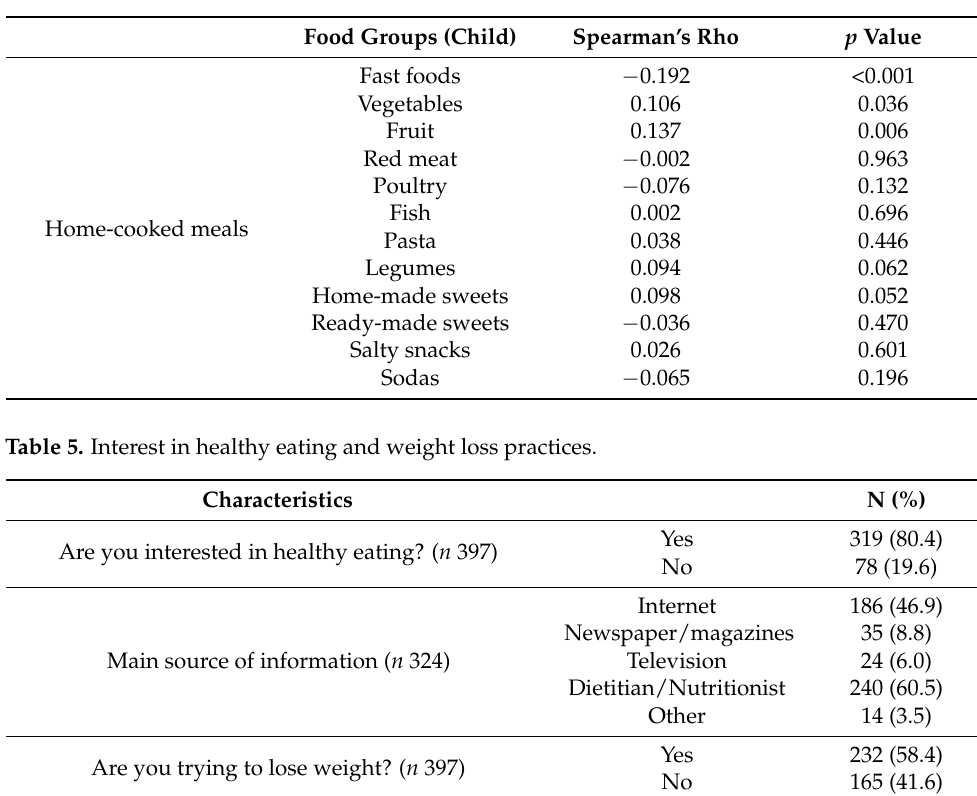
Figure 1. Frequencies of consumption of main meals for parents and their child before and during lockdown and respective changes ( n 397). * denotes significance ( p < 0.05). Table 3. Changes in parents’ food practices and dietary habits ( n 397). Table 4. Correlations of changes in frequency of preparing home-cooked meals and child’s consump- tion of food groups ( n 397).